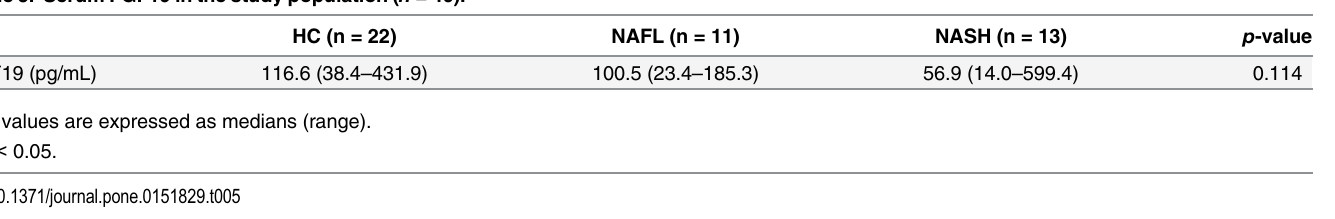
Table 5. Serum FGF19 in the study population ( n = 46).